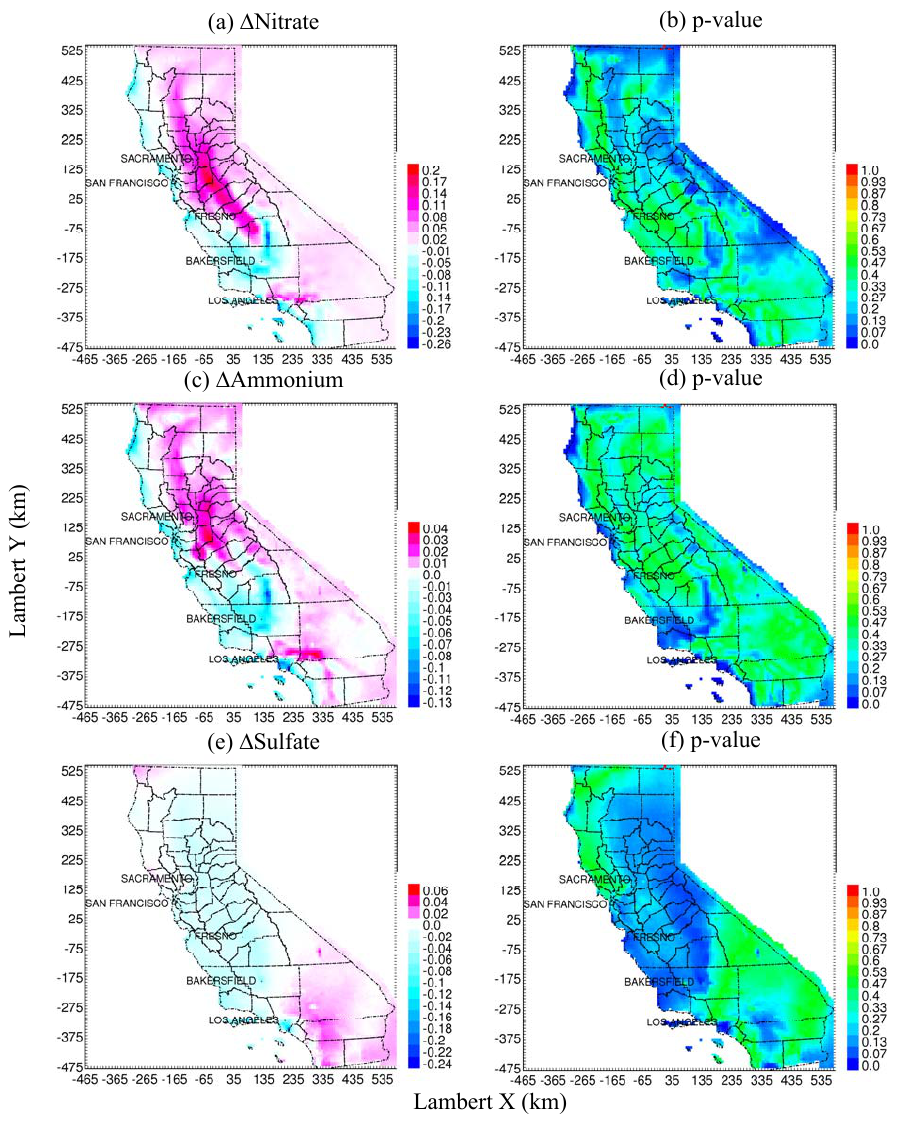
Fig. 7: Changes in annual average secondary PM 2.5 concentrations, and their corresponding p-values in CA likely to occur in the future (2047-53) due to climate change from the present-day (2000-06). The p-value quantifies the likelihood that average future concentrations are equal to present day concentrations.